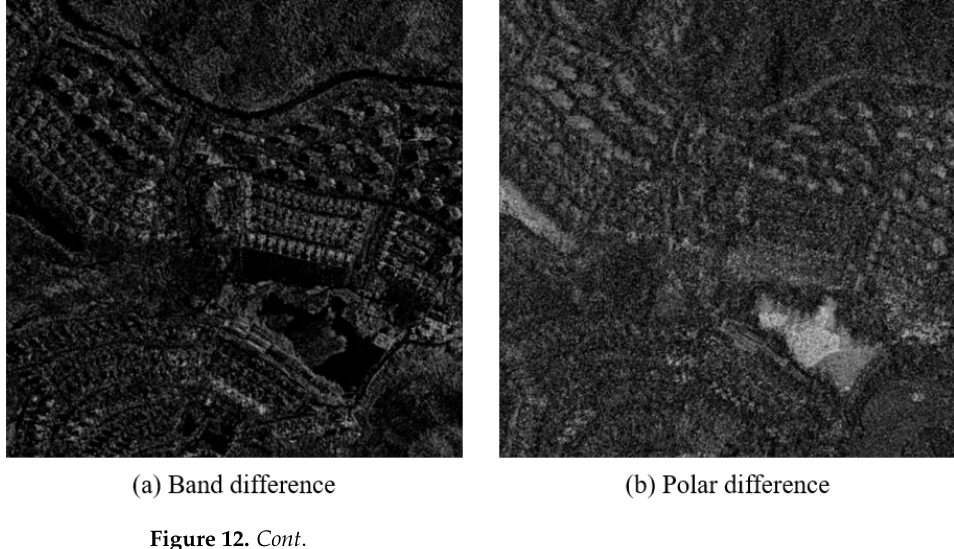
Figure 12. Complete colorization fusion results of scene 2: ( a ) Band difference map; ( b ) polarization difference map; ( c ) PCA fusion; ( d ) wavelet fusion; ( e ) NSCT fusion; ( f ) NSST fusion; and ( g ) pro- posed method fusion. 3.3. Comparison of Evaluation Indexes This section contains the analysis of various evaluation indexes for the colorized fu- sion images in Figures 11 and 12. The evaluation indexes include average gradient (AG), information entropy (IE), standard deviation (STD), correlation coefficient (CC), and structural similarity index measure (SSIM). The Ka-band SAR image is used as the refer- ence image in the CC and SSIM indexes.